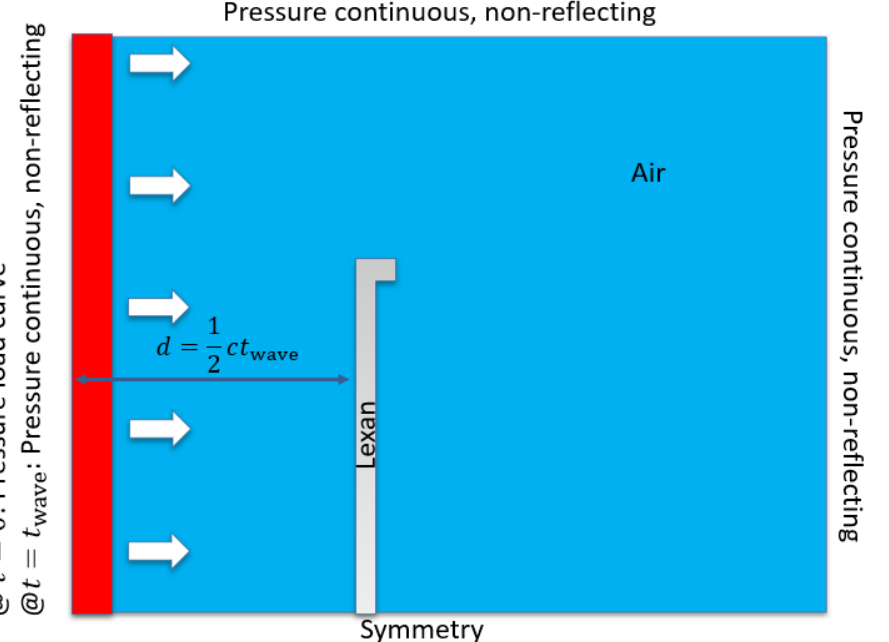
Figure 6. A “cartoon” depiction of the setup of the blast-structure interactions simulations with materials and boundary conditions labeled. (Not to scale)